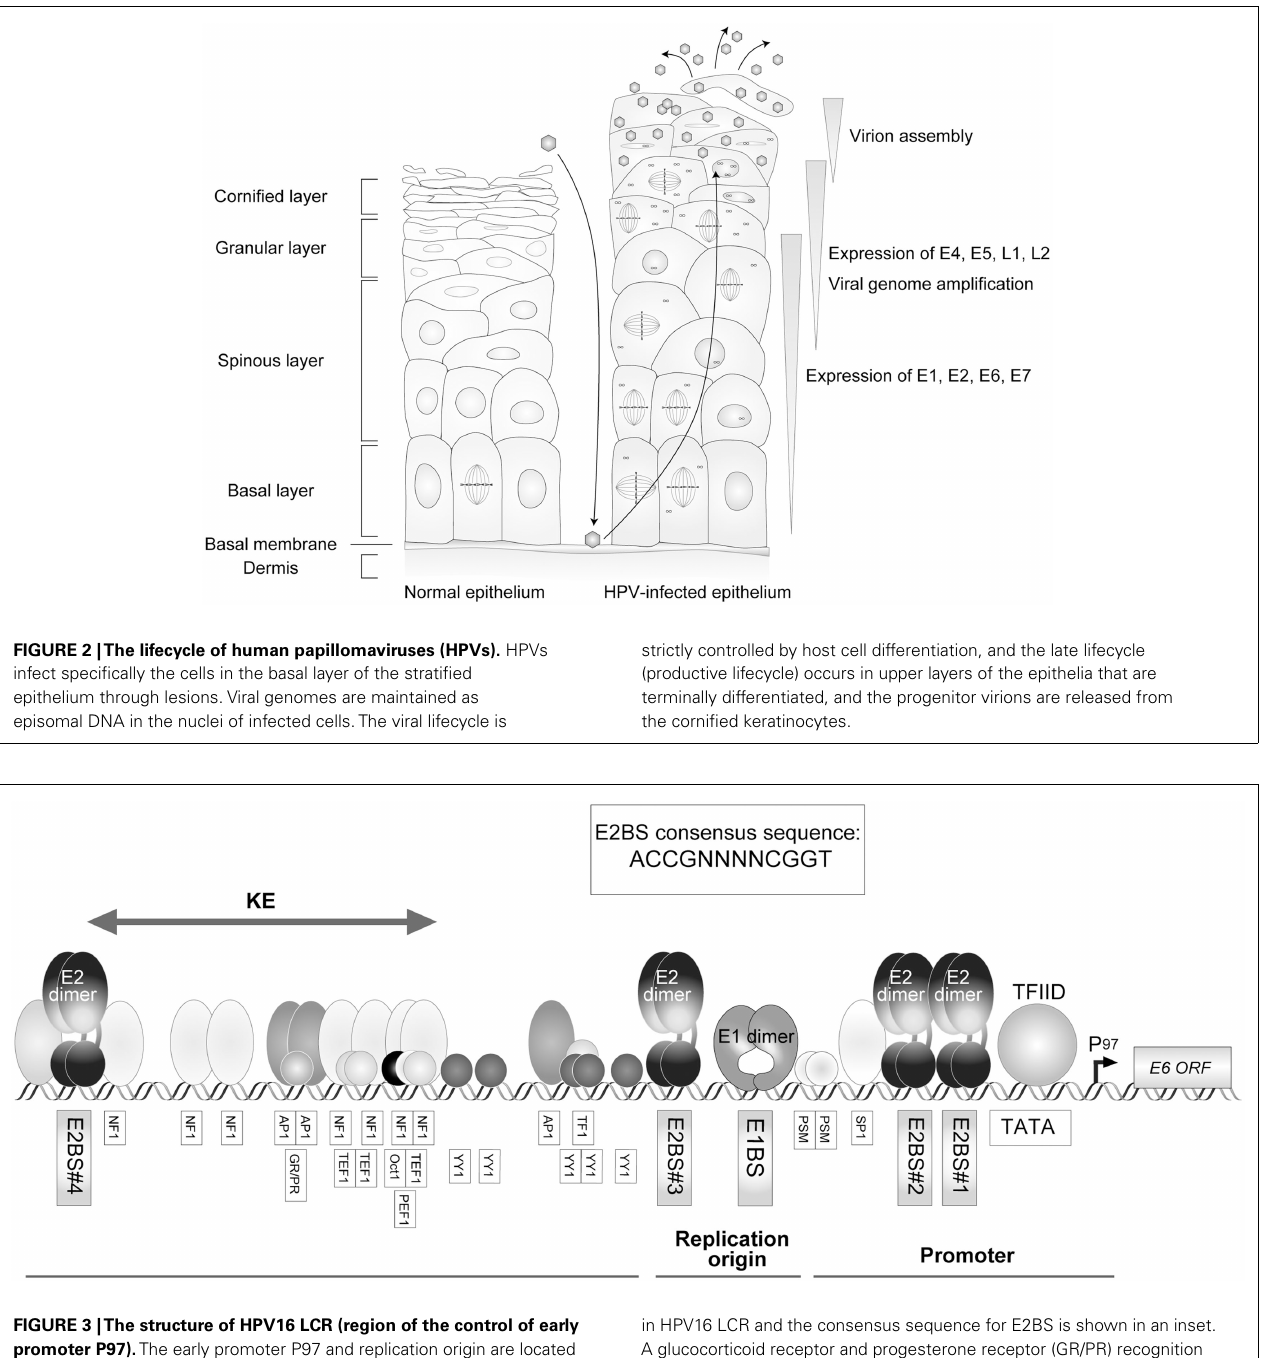
FIGURE 3 |The structure of HPV16 LCR (region of the control of early promoter P97). The early promoter P97 and replication origin are located in LCR, which are regulated by various cellular factors. Activity of P97 is regulated by AP-1, NF1, SP1,TFIID,TF1, Oct-1, PSM, and the viral transcription factor E2. Four E2-binding sites (E2BS) have been identified